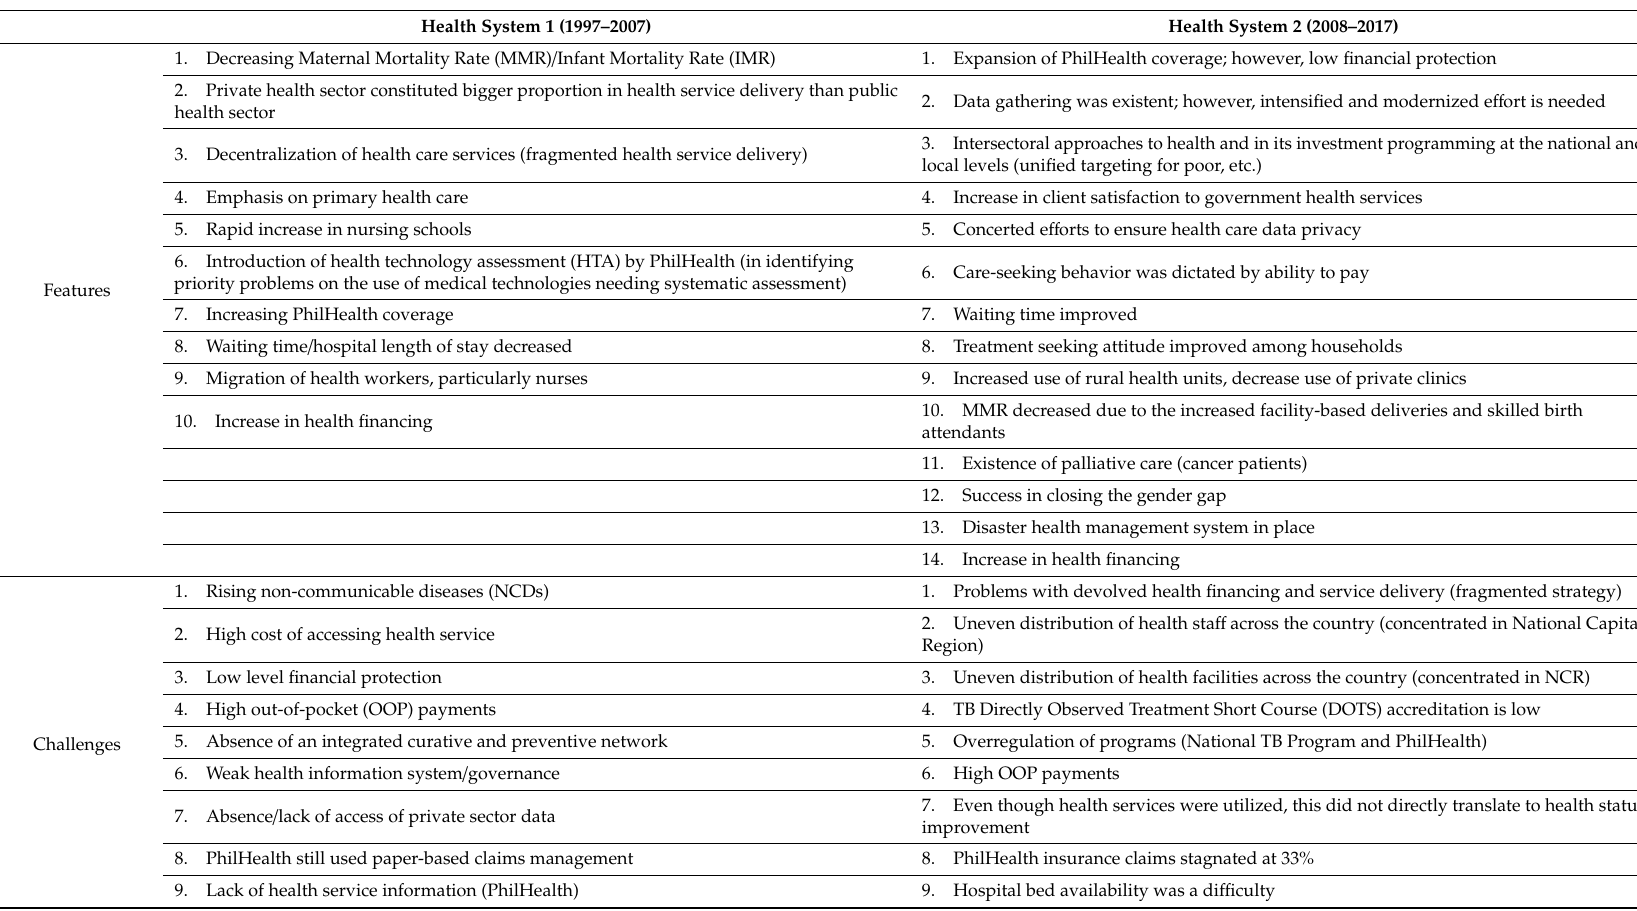
Table 2. Summary table of the Features, Challenges, Reforms, and the pertinent Laws / Statutes passed and enforced during the respective health